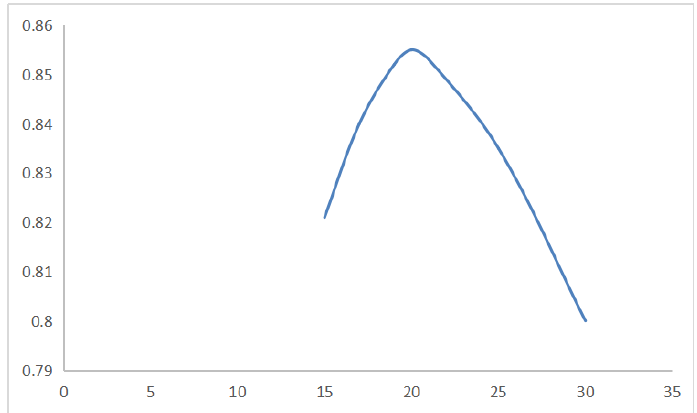
Figure 10. Bleu_1 of different batch sizes. It shows the trend of Bleu_1 when the other parameters were constant and only the batch size was changed. As the batch size increased, Bleu_1 increased first and then decreased, and the effect of batch size on Bleu_1 was obvious, so a suitable batch size was necessary.